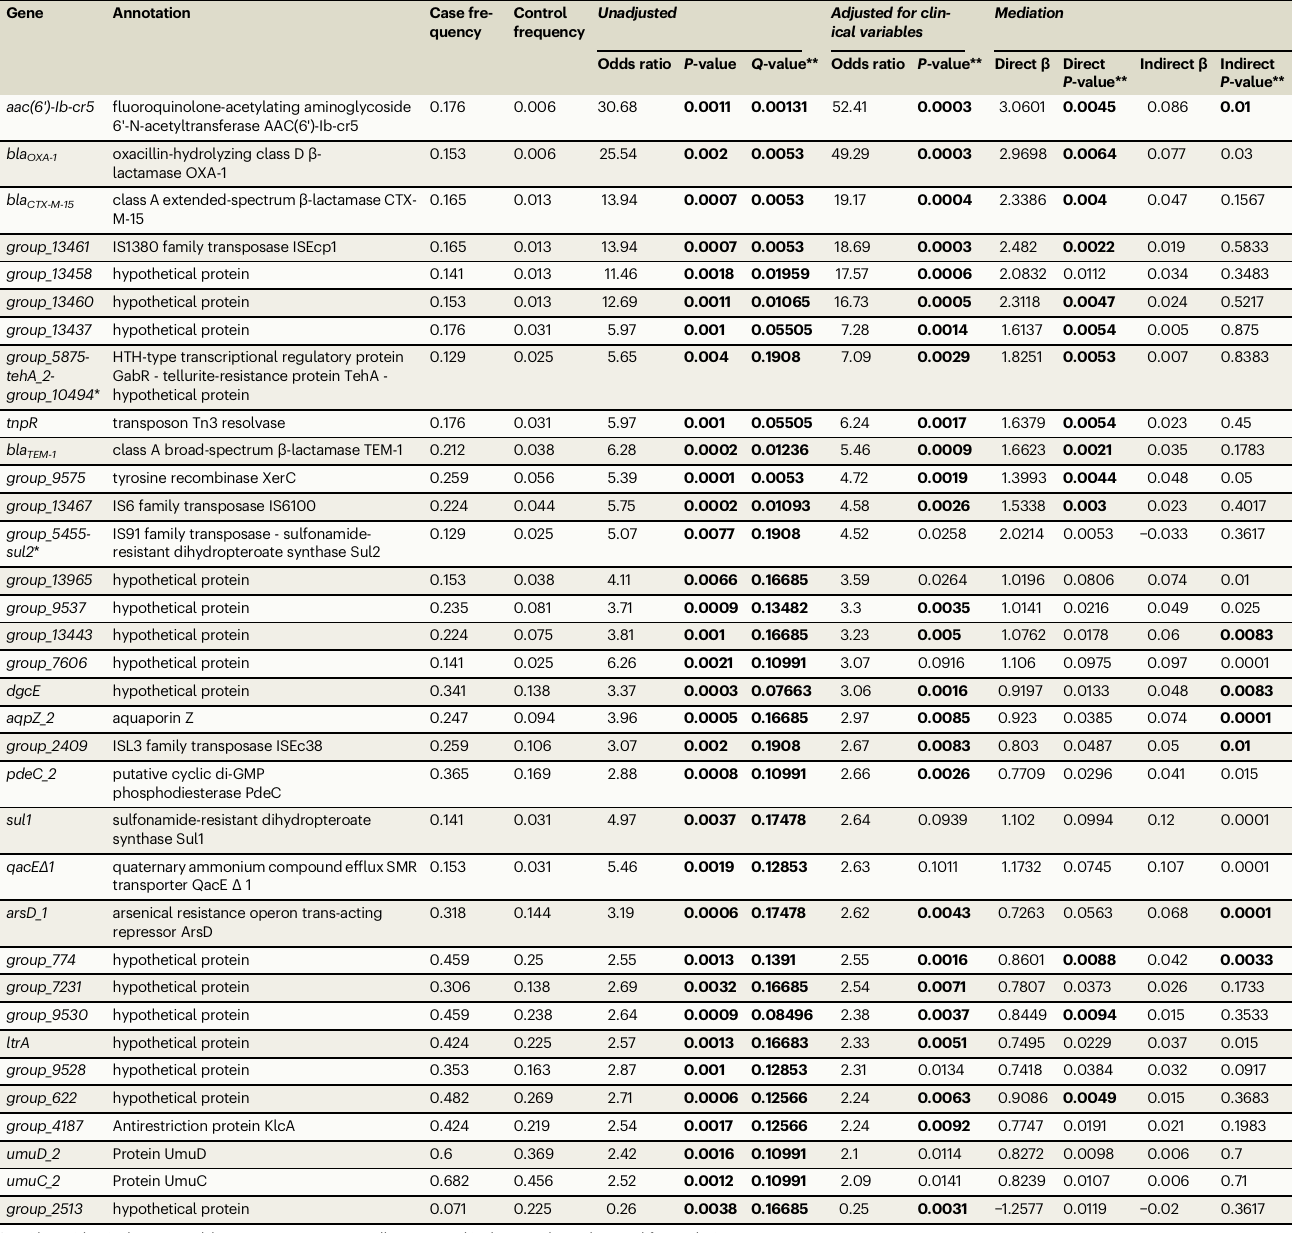
Table 2 | Genes associated with patient case status Gene Annotation Casefre-